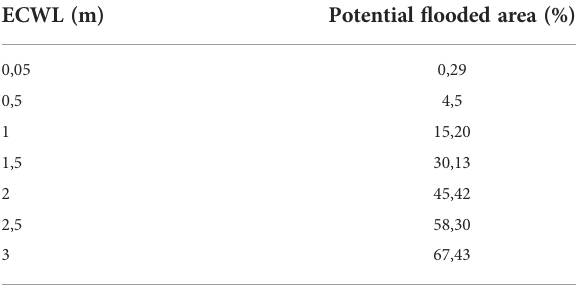
TABLE 1 Potential fl ooded area (%) at Saint Louis for ECWL